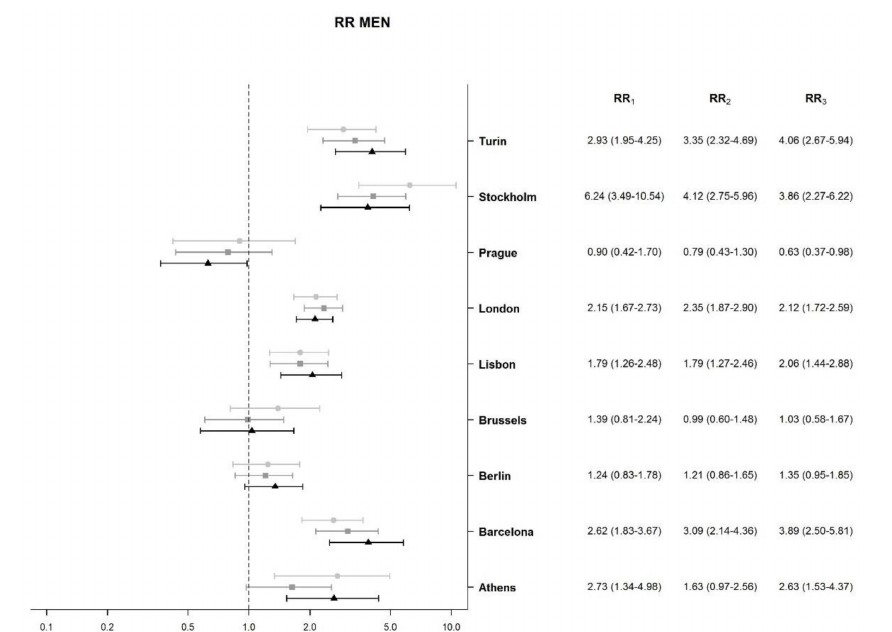
Figure 1. Association between socioeconomic deprivation index and liver cirrhosis mortality, relative risk (RR), and 95% credible intervals (CI) for men in nine urban areas. Notes: RR compares liver cirrhosis mortality of the 95th percentile value of socioeconomic deprivation (severe deprivation) to the 5th percentile value (low deprivation). RR 1 : RR in the first period (2000–2003); RR 2 : RR in the second period (2004–2008); RR 3 : RR in the third period